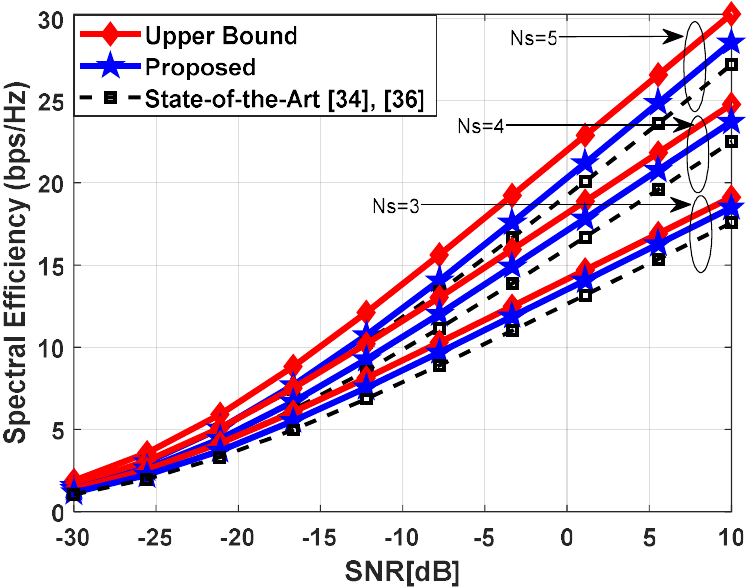
Figure 6. Spectral efficiency vs. SNR in a mm-Wave propagation environment with UPA such that N cl = 4, N ray = 10 and 10 ◦ spread angle. System parameters are set as N t = N rel = 100, N r = 25, N s = 3, 4, 5.